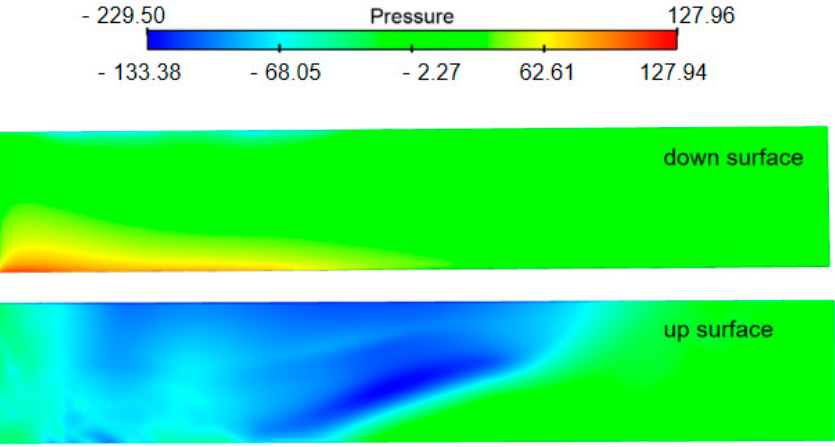
Figure 7. Pressure contour on the surfaces of a blade.